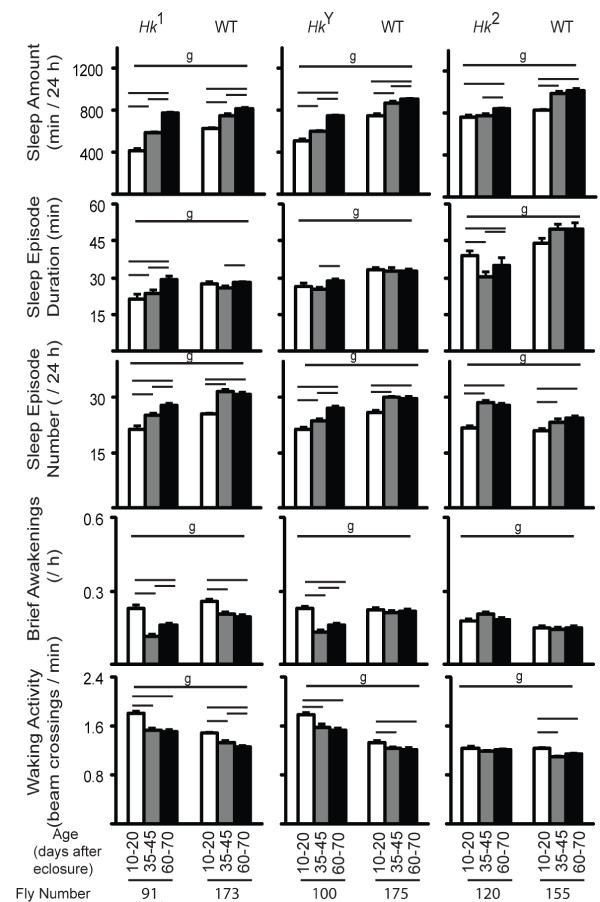
Sleep parameters and waking activity at different ages in flies that lived at least 73 days. Values are mean + SEM (eleven 24-hour intervals averaged per each fly, and then averaged across all flies). Genotype (g) effects were tested across all ages (Kruskal-Wallis test, p < 0.05). Horizontal bars indicate significant age-related effects within each genotype (Friedman test followed by Wilcoxon signed-rank test, p < 0.05).